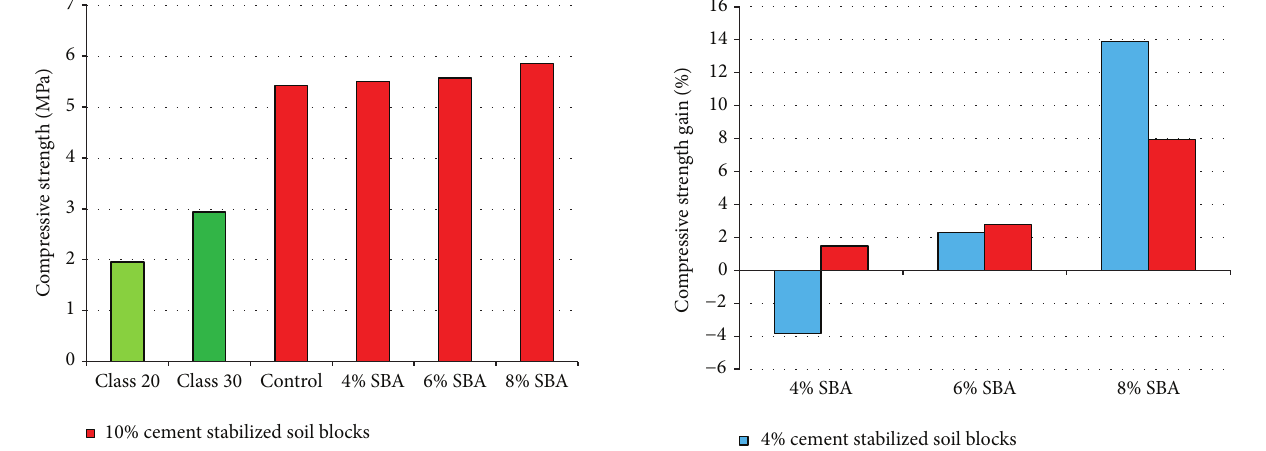
Figure 4: Compressive strength of 10% cement stabilized soil blocks admixed with SBA. Figure 5: Percentage of compressive strength gain with